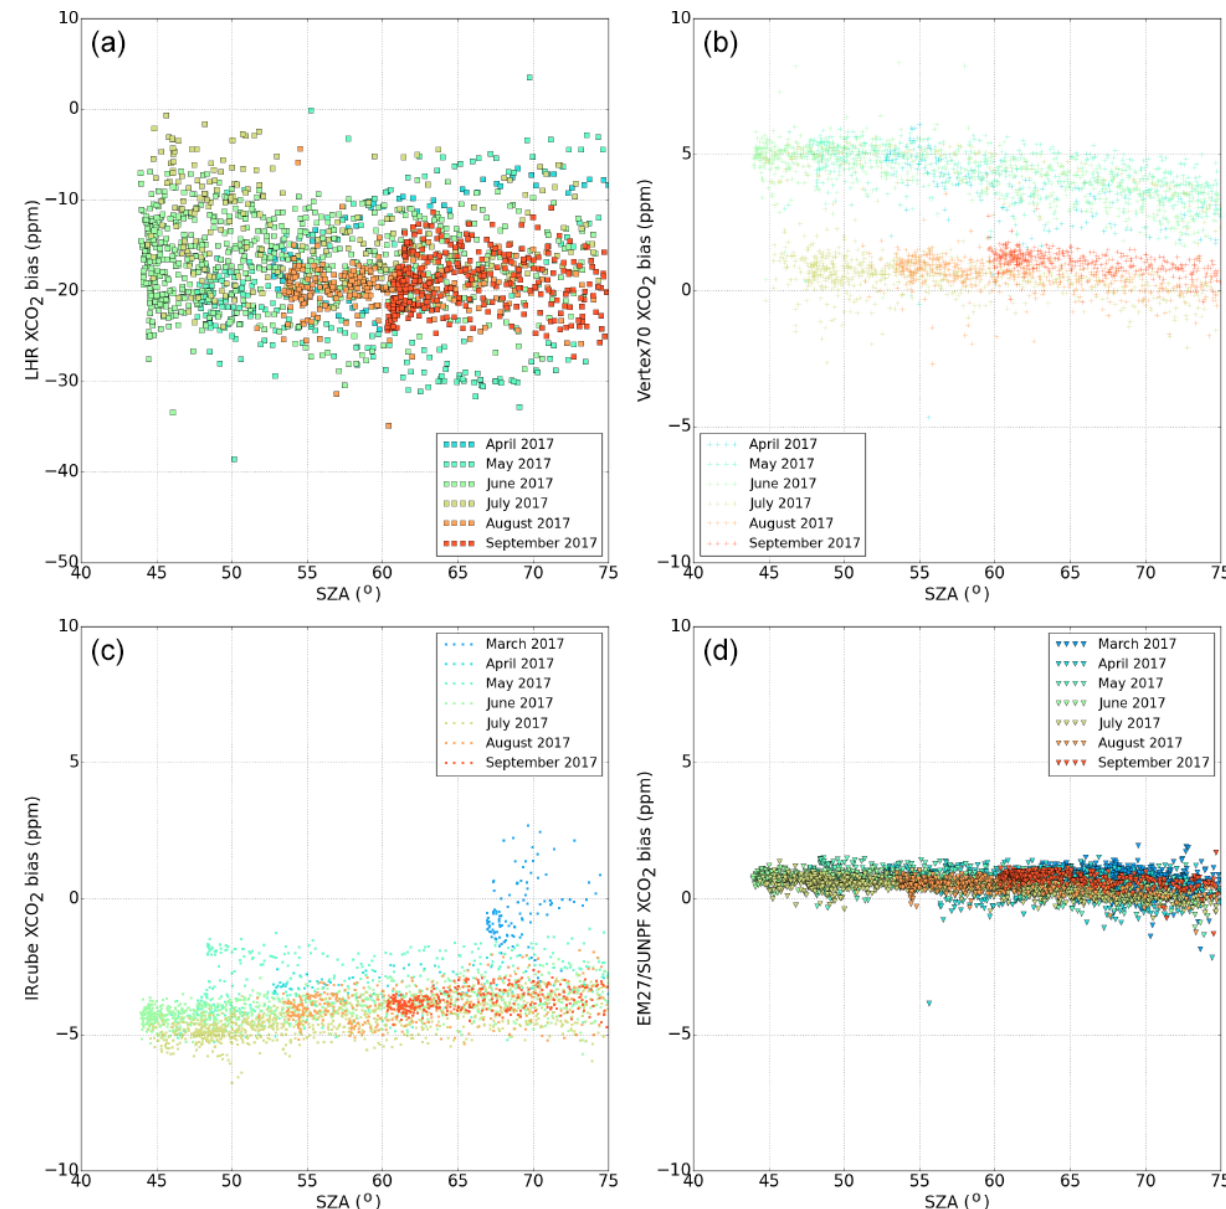
Figure E2. XCO 2 bias relative to HR125LR for each instrument plotted with respect to the solar zenith angle: LHR (a) , Vertex70 (b) , IRcube (c) , EM27/SUN (d) . The colours represent the measurement performed during the different months of the